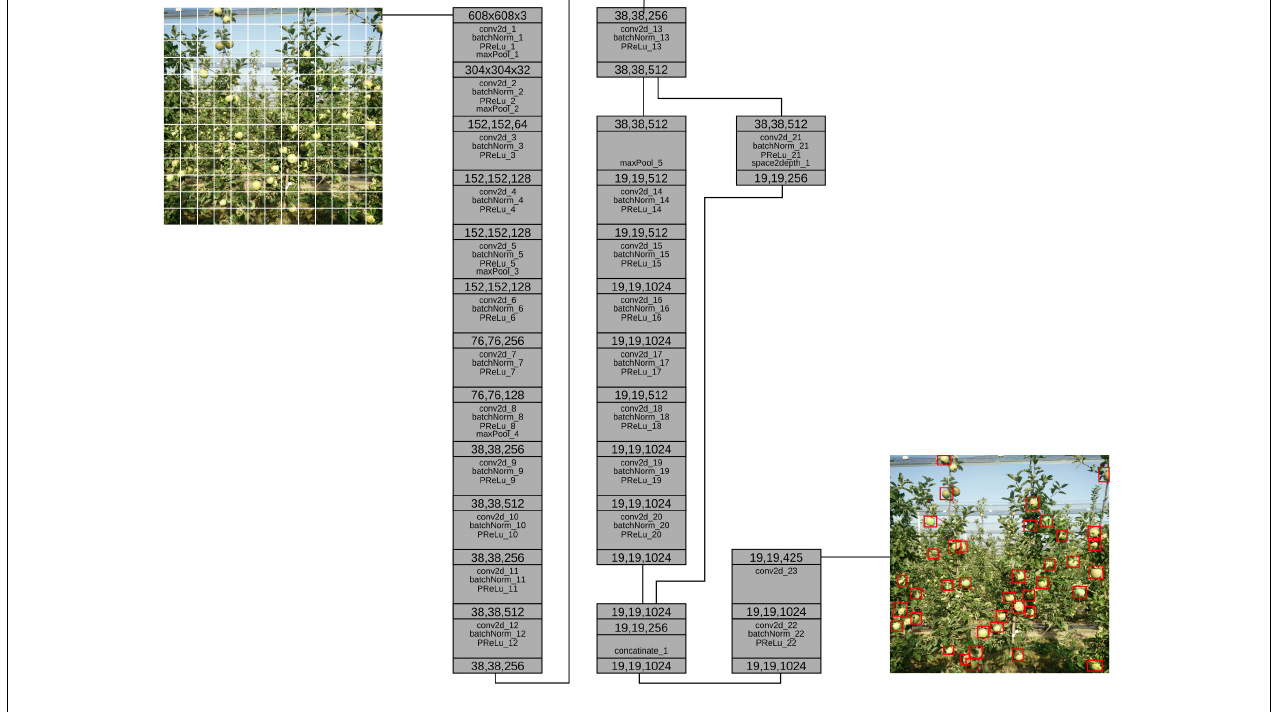
FIGURE 1 | YOLO model with 24 Layers.